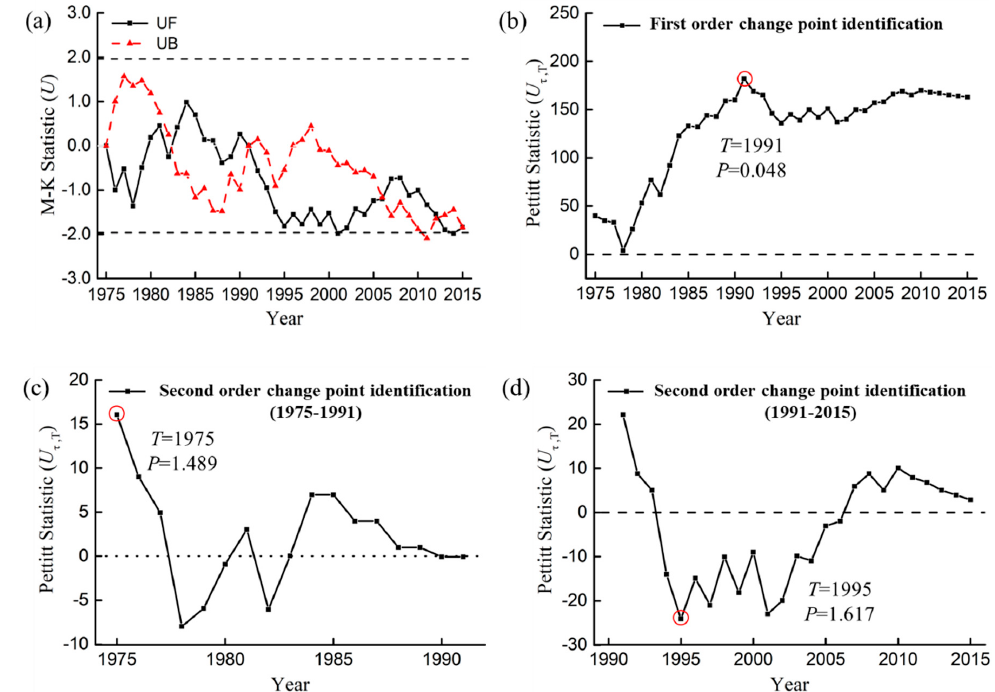
Figure 4. Inflow sediment time series combinatorial mutation test. ( a ) M–K test; ( b ) First order change point identification; ( c ) Second order change point identification (1975–1991); ( d ) Second order change point identification